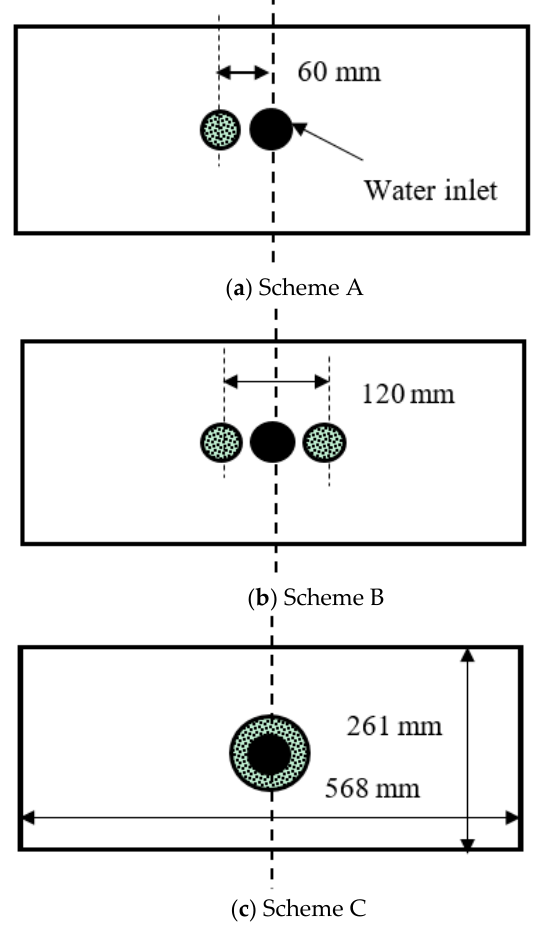
Figure 6. Top-view schemes of the bottom-blowing plug.